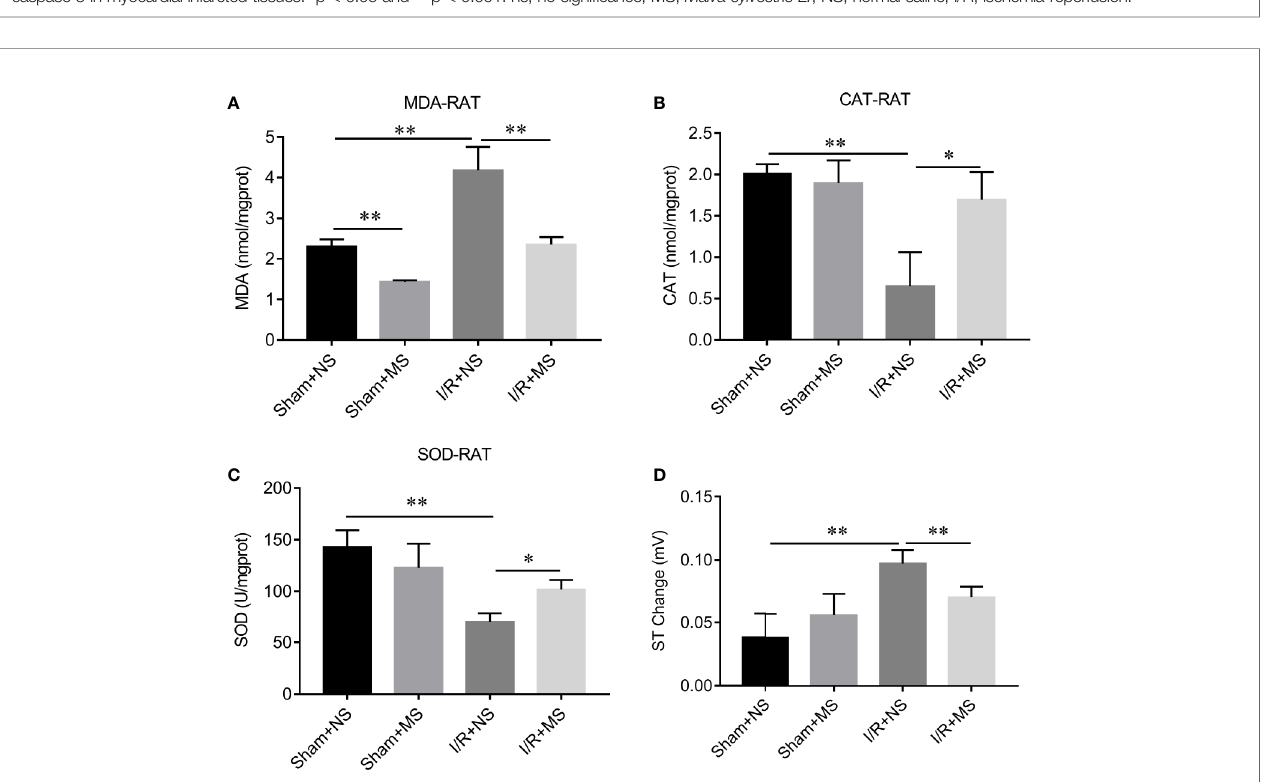
FIGURE 3 | The effects of Malva sylvestris L. on MDA, CAT, and SOD in I/R rat model. (A – C) ELISA was performed to determine the concentration of MDA (A) , CAT (B) , and SOD (C) in I/R rat model with or without MS pre-treatment. (D) Electrocardiogram (ECG) records the ST changes in I/R rat model with or without MS pre-treatment. *p < 0.05 and **p < 0.01. MS, Malva sylvestris L.; NS, normal saline; I/R,